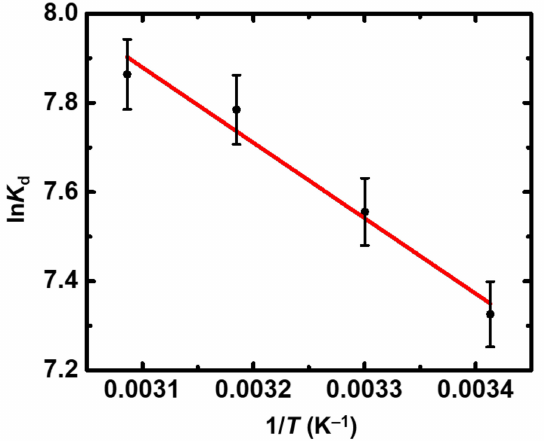
Figure 9. ln K d as a function of 1/ T for the sorption of Th(IV) by X-alginate aerogels at an initial Th(IV) concentration equal to 5 × 10 − 4 mol L − 1 . Experimental conditions are as follows: contact time 24 h, pH 3.0, adsorbent dosage 0.4 g L − 1 , agitation rate 125